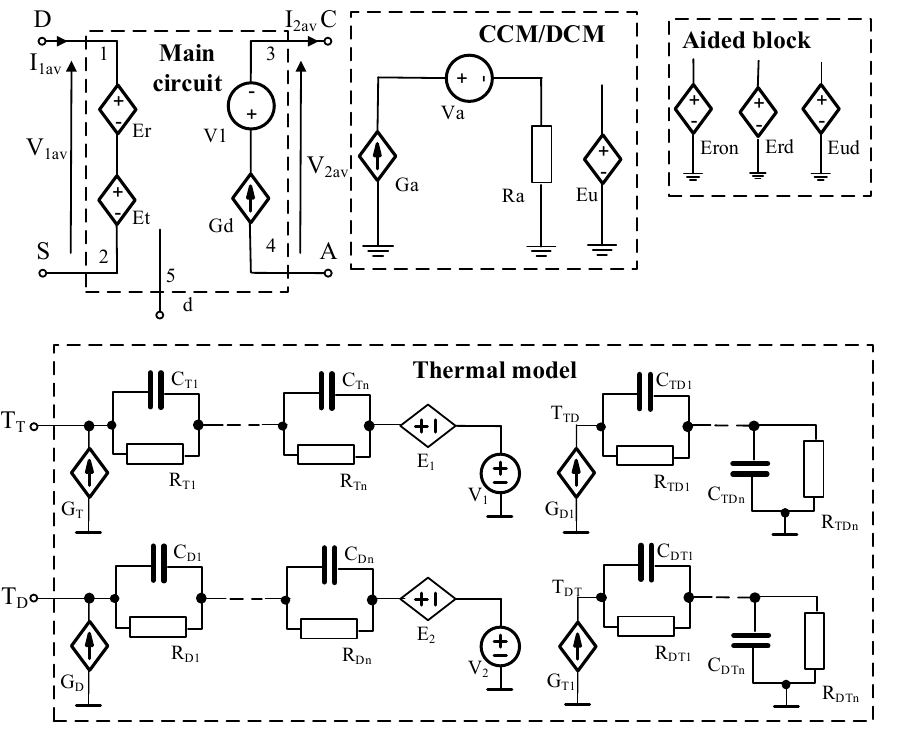
Figure 1. Network representation of the electrothermal average model of diode-transistor switch (DTS).